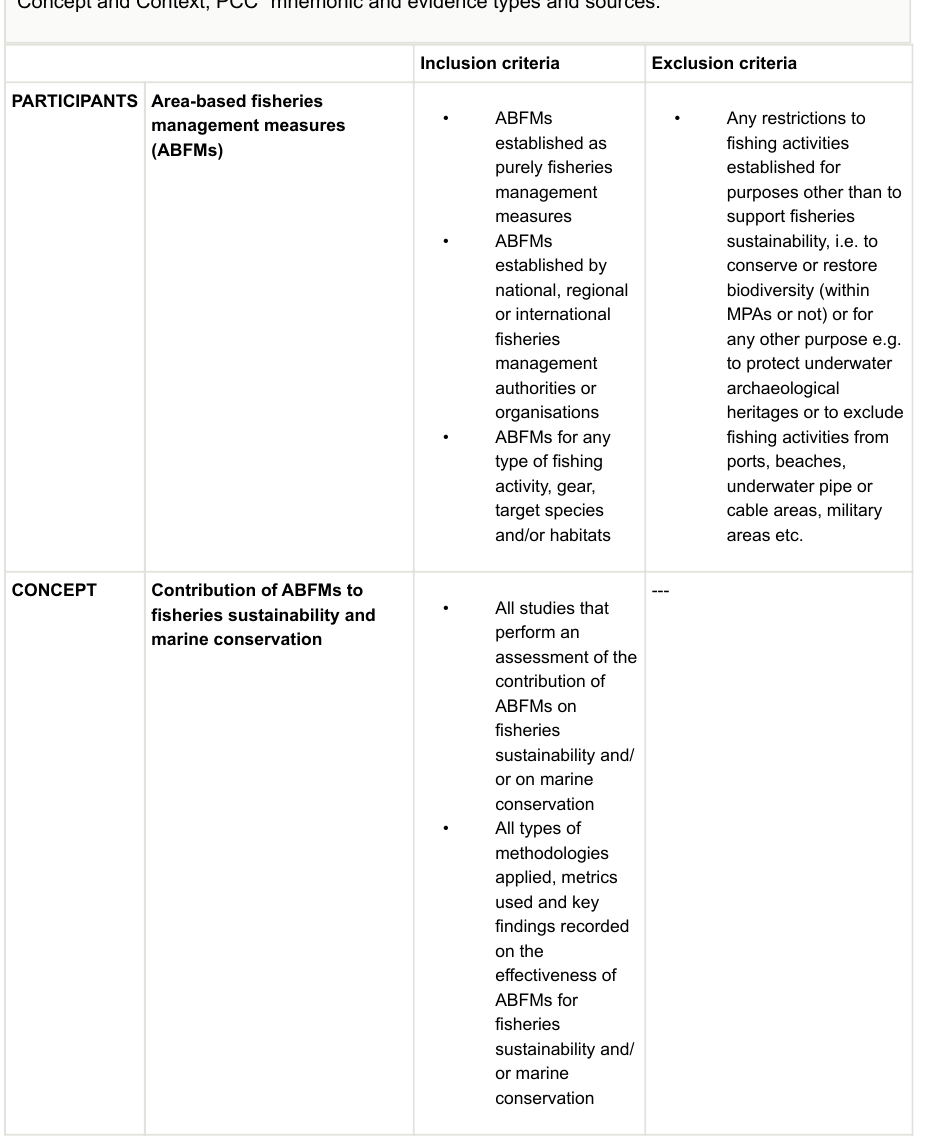
Table 3. Inclusion and exclusion criteria for the Scoping Review in correspondance with the "Participants, Concept and Context, PCC" mnemonic and evidence types and